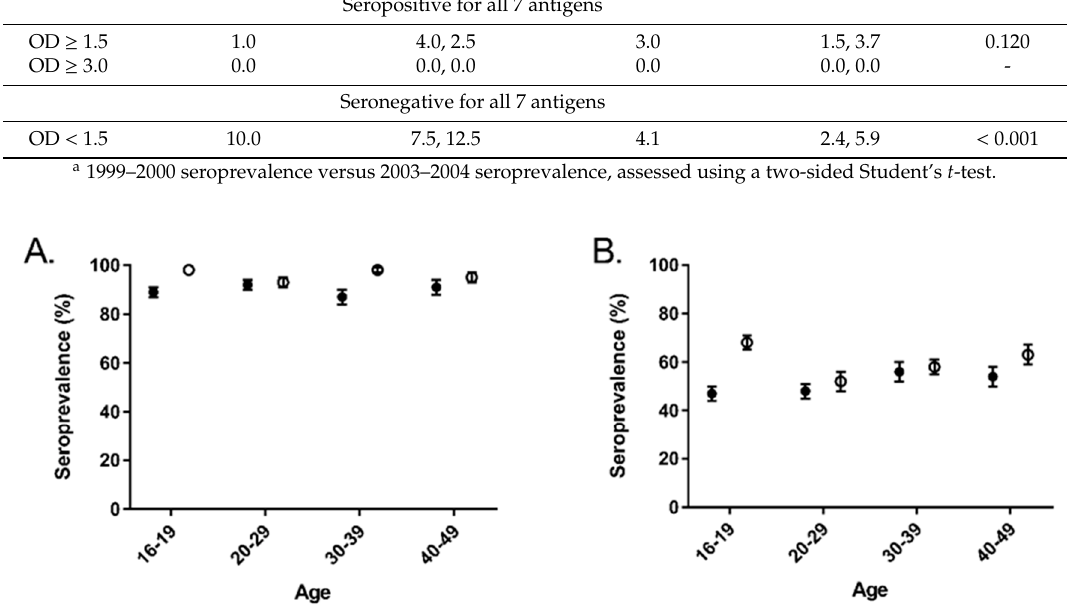
Figure 1. Overall seroprevalence and serologic evidence of recent infection by age and the National Health and Nutrition Examination Survey (NHANES) study cohort. Closed circles, 1999 to 2000 and open circles, 2003 to 2004. ( A ) Proportion seropositive defined as OD ≥ 1.5; ( B ) Proportion with evidence of recent infection defined as OD ≥ 3.0.